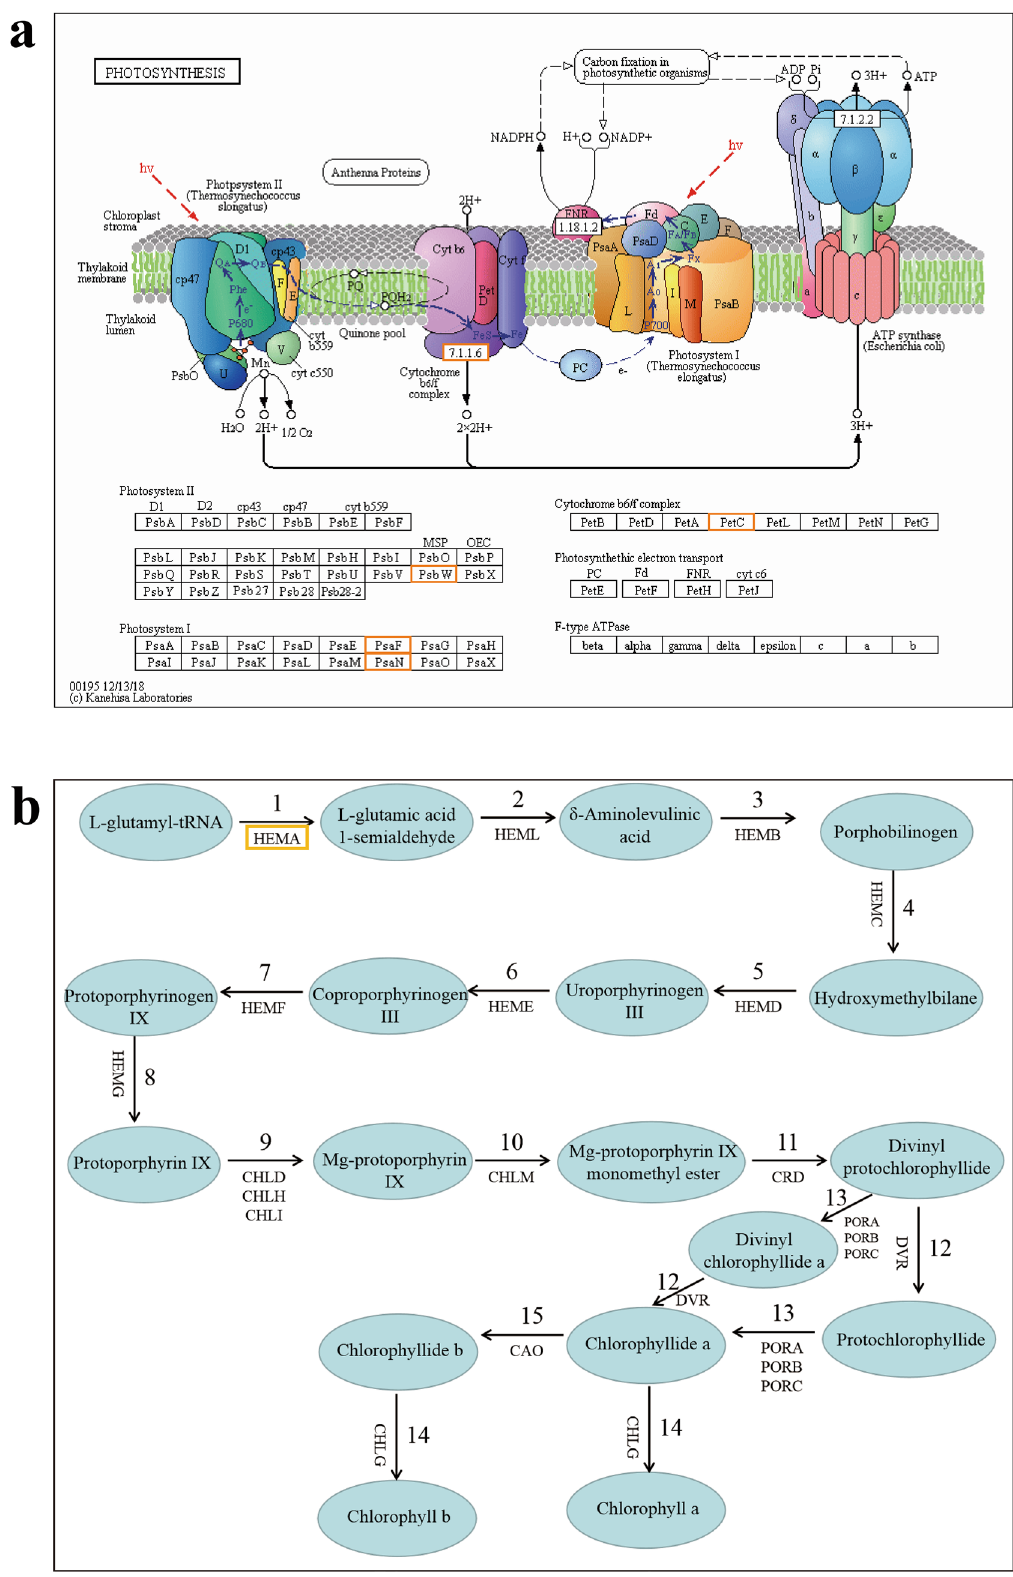
Figure 7. The down-regulated DEGs of “ photosynthesis” pathway ( a ) and “chlorophyll biosynthesis” pathway ( b